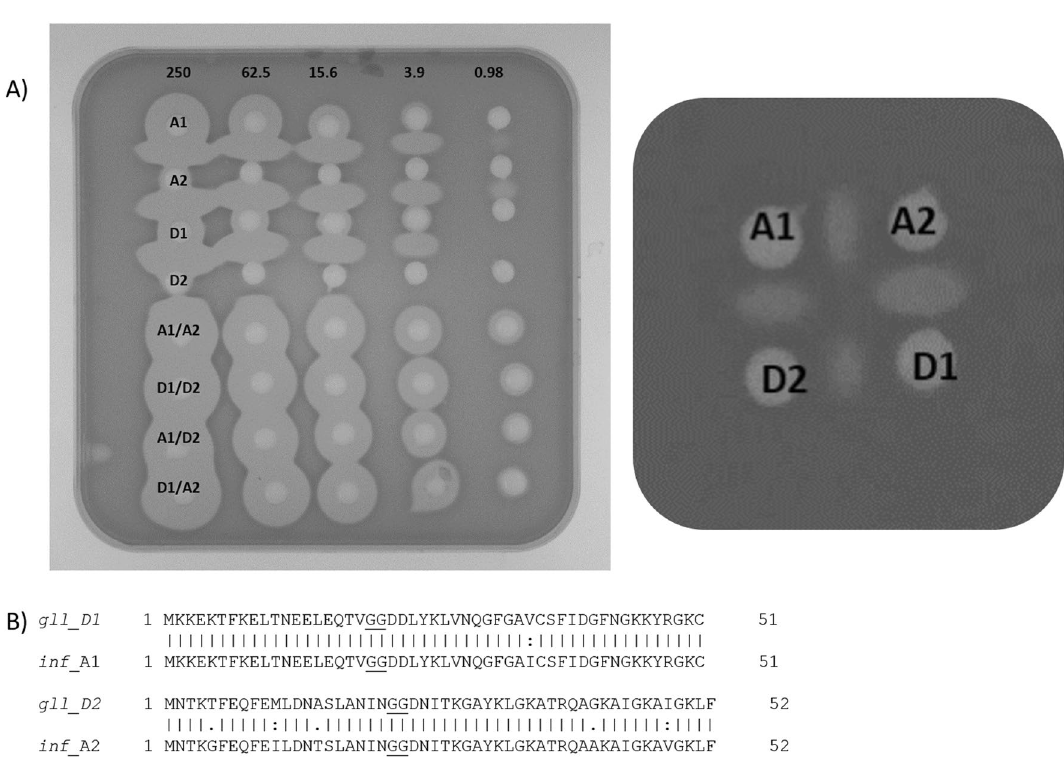
Figure 4. ( A ) Mixing gallocin D and infantaricin A peptides indicates that any combination of the alpha and beta peptides results in activity, concentration in µM across the top. ‘Rugby ball’ shape seen between wells indicates where the peptides meet following diffusion into the media, showing complementary activity. ( B ) Alignment of sequences of the prepeptides from both species, the double glycine cleavage point is